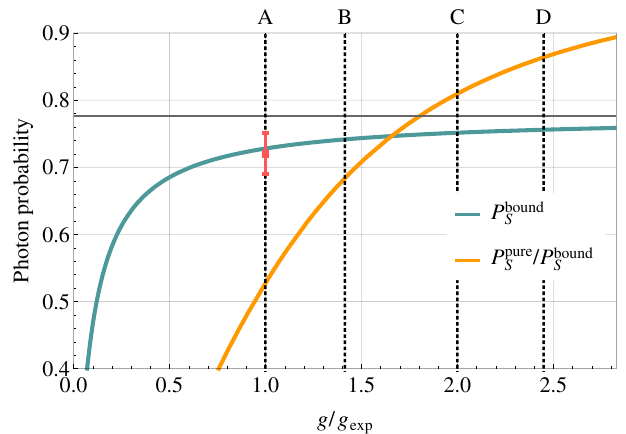
FIG. 8. Possible efficiency improvements in our existing and ion-cavity system. Theoretical predictions for P bound S / P bound , calculated via Eq. (1), with j = 0 for P pure , when P pure S S S increasing the ion-cavity coupling strength g over its current value g exp . Labels A–D represent possible schemes in our sys- tem. Theoretical predictions use mean values for experimental parameters. Scheme A corresponds to the current experimental √ 0.5. Scheme B corresponds configuration (Fig. 2), where ζ = to changing the orientation of the drive beam and magnetic field axis to be parallel to the cavity axis, such that ζ = 1. Schemes C and D correspond to coupling two and three ions, respectively, in super-radiant entangled states to the cavity, in addition to scheme B. Red dot with error bars: measured effi- ciency for a drive field with (cid:8) = 14 MHz (Sec. III). Horizontal gray line: photon escape probability through the cavity output mirror P esc = T 2 /( T 2 + α loss ) =